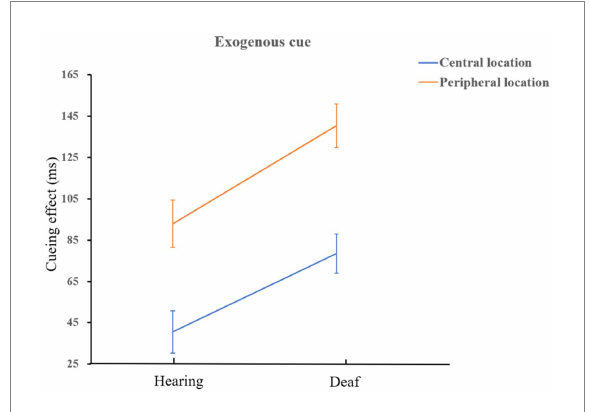
FIGURE 5 The interaction of group and location when cues are